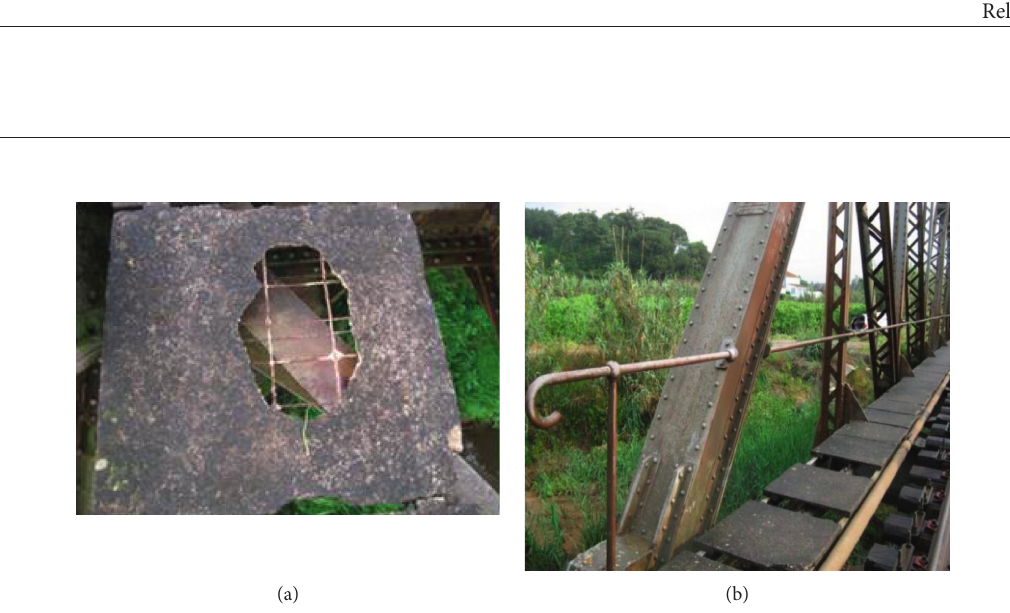
Figure 6: User safety condition assessment: (a) sidewalks; (b) parapets.